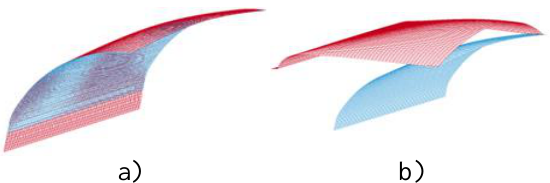
Figure 4. Transverse deflection in the central part of the shell at the beginning of the extension of